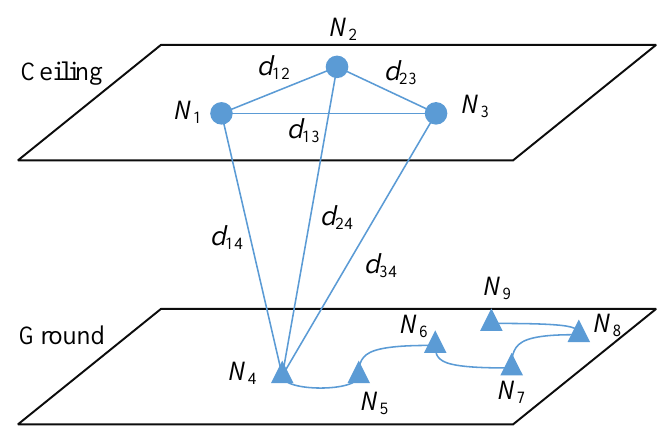
Figure 3. The illustration of the 3D self-localization